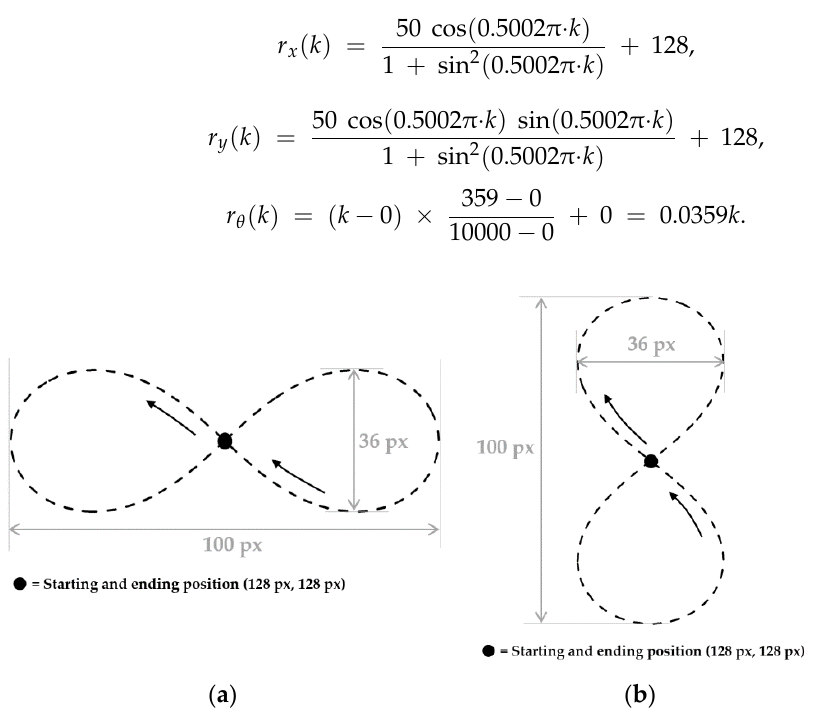
Figure 16. ( a ) ∞ -shaped trajectory and ( b ) 8-shaped